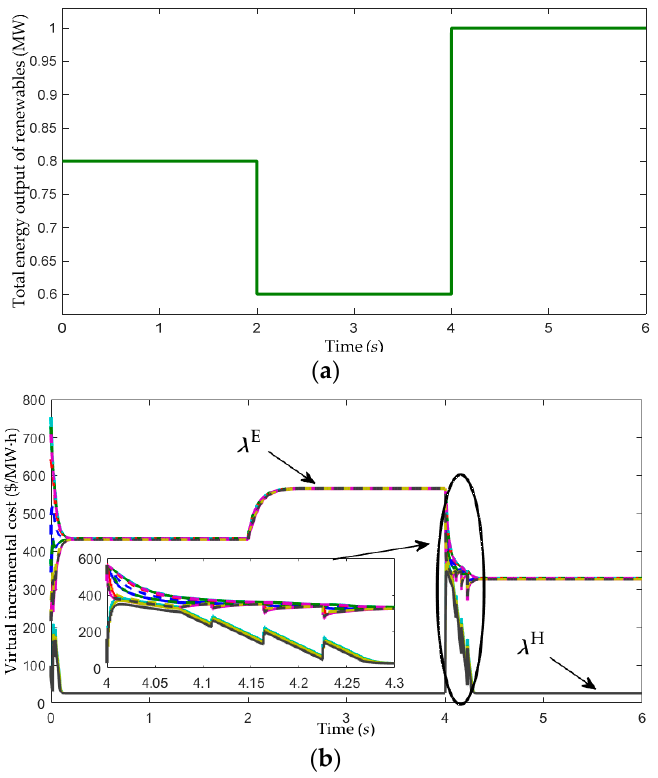
Figure 10. Real-time optimization of distributed HEEM by ACA. ( a ) Electrical energy fluctuation of renewables; ( b ) virtual incremental cost.